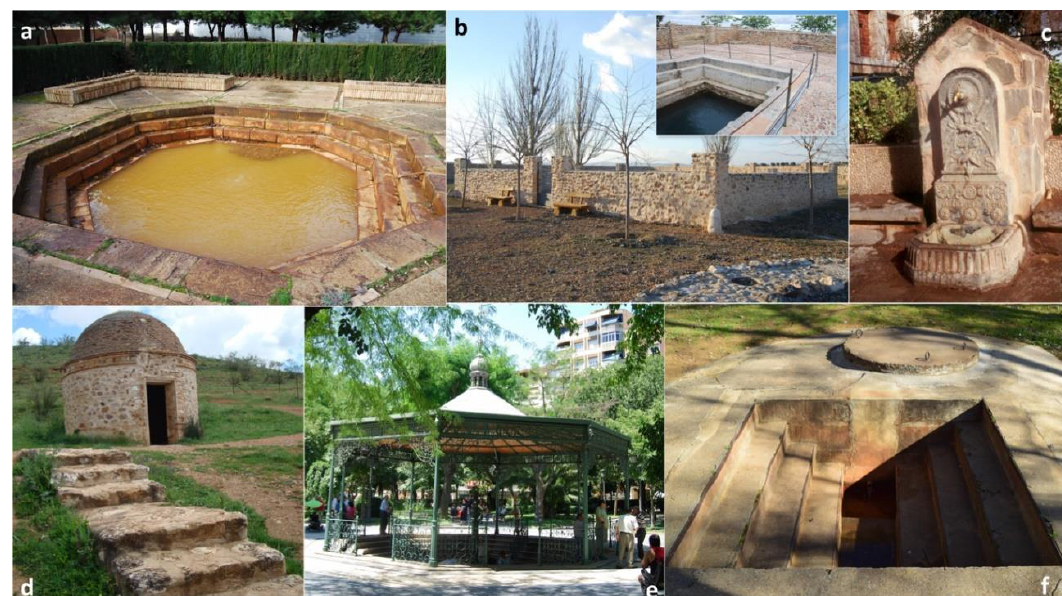
Figure 11. ( a ) Villar del Pozo Bath; ( b ) El Hervidero Bath and detail of the pool (Carrión de Calatrava); ( c ) carbonic sour water fountain (Valenzuela de Calatrava); ( d ) carbonic sour water fountain (Pozuelo de Calatrava); ( e ) Fuente Agria (Puertollano); ( f ) carbonic sour water fountain (Piedrabuena).